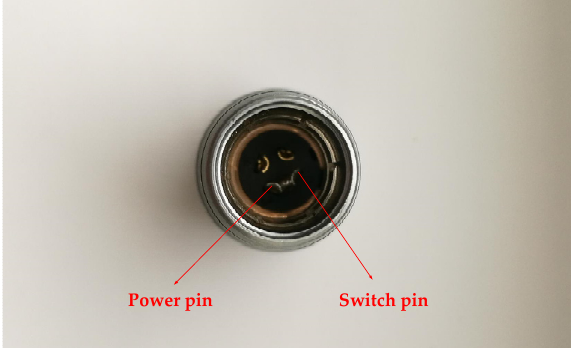
Figure 12. The welded of power pin with switch pin.